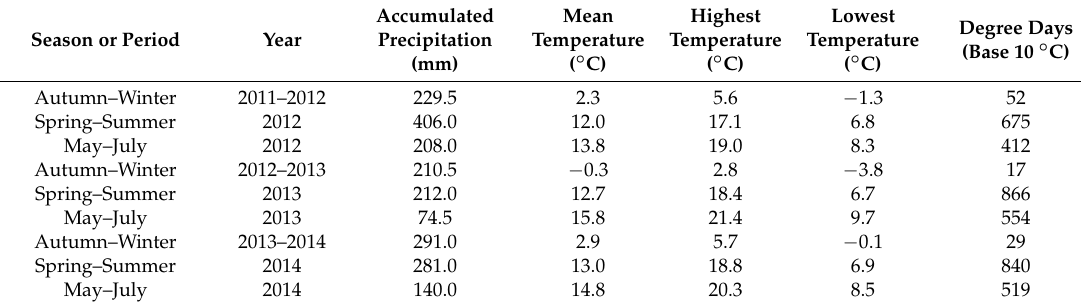
Table 1. Summary of weather data recorded in the locality of Ekhaga during the three years of production of 19 winter wheat genotypes. Weather data recorded between May and July of each year are shown in order to highlight the growth period of winter